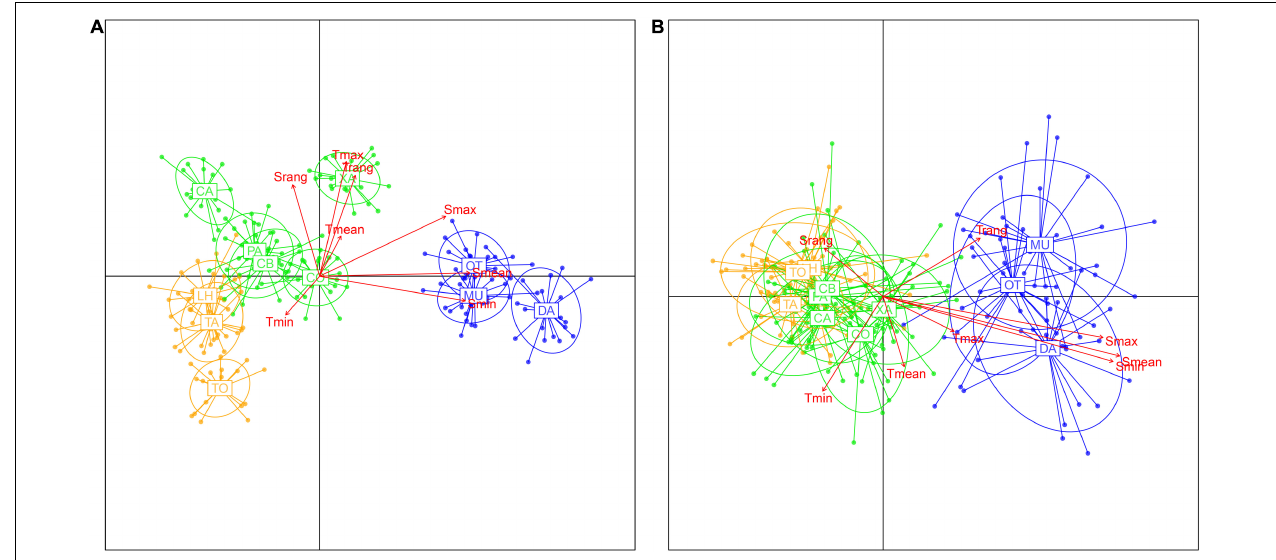
FIGURE 6 | Results of the DAPCs using populations as prior groupings for (A) the “neutral” loci and (B) the “outlier” loci datasets, and retaining 160 and 40 PCs, respectively, as indicated by “xvalDapc” function. The fitted vectors of the environmental variables considered are superimposed.